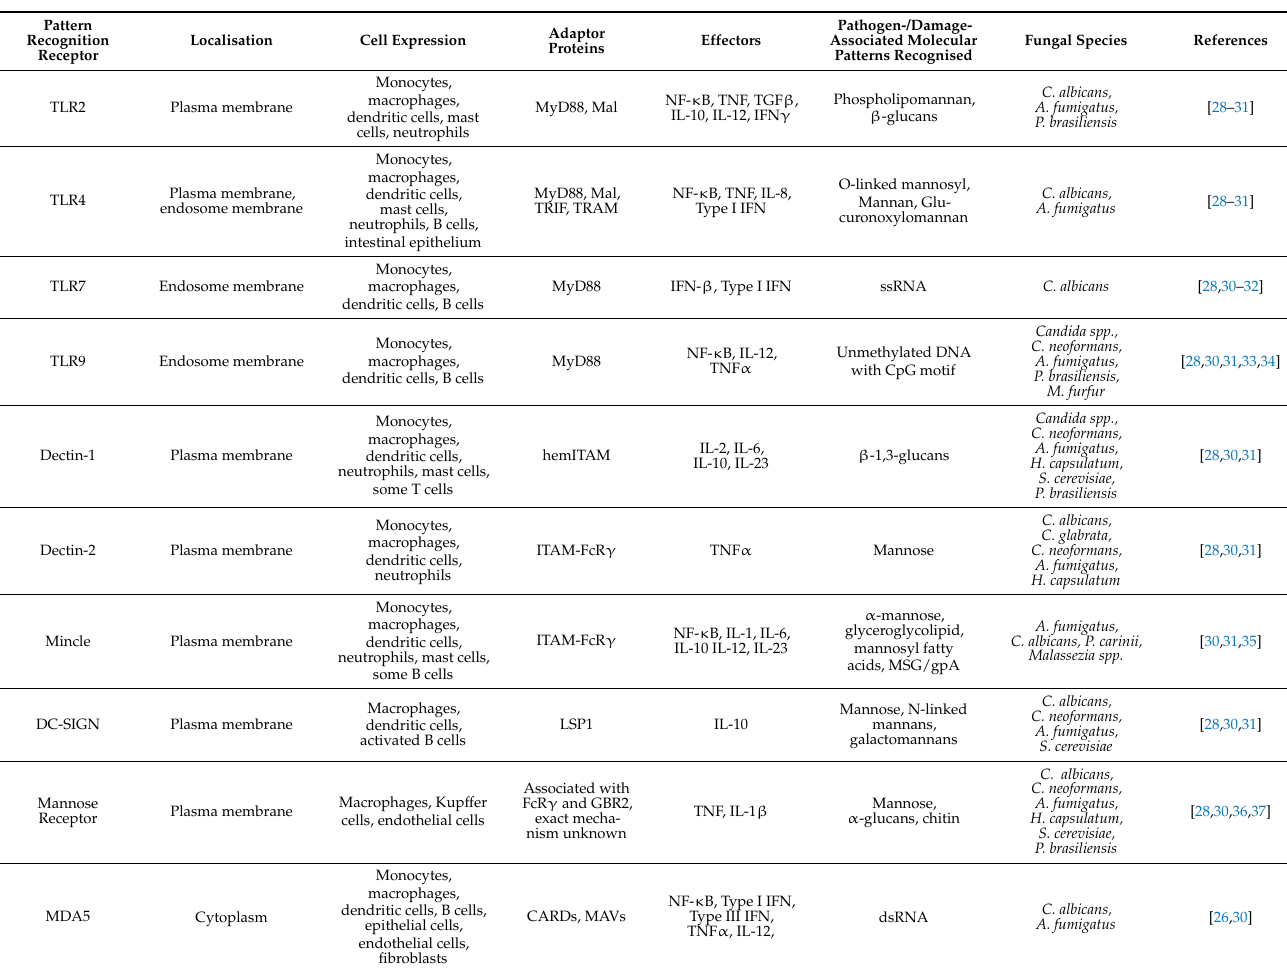
Table 1. Pattern recognition receptors in fungal